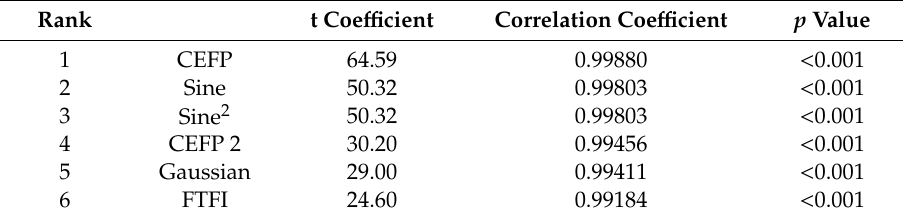
Table 3. Correlation of the values estimated with the six best models from Figure 3 to average monthly surface water temperature ( ◦ C) in Polish lakes in the years 1971–2010. Source: Author calculations according to data compiled by Sobolewski at al. [34] based on the data of the Institute of Meteorology and Water Management. Rank t Coe ffi cient Correlation Coe ffi cient p Value 1 CEFP 64.59 0.99880 < 0.001 2 Sine 50.32 0.99803 < 0.001 3 Sine 2 50.32 0.99803 < 0.001 4 CEFP 2 30.20 0.99456 < 0.001 5 Gaussian 29.00 0.99411 < 0.001 6 FTFI 24.60 0.99184 <